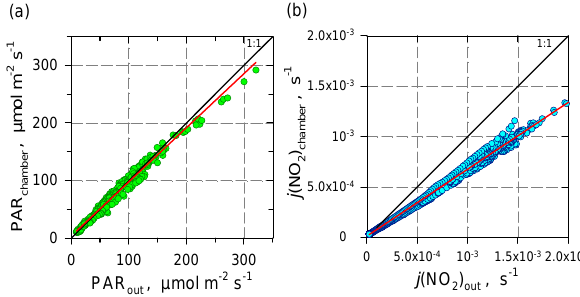
Fig. 9. Simultaneous measurements of radiation in and outside a Figure 9. Simultaneous measurements of radiation in and outside a chamber. (a) 3 chamber. (a) Photosynthetically active radiation PAR (slope=0.94, Photosynthetically active radiation PAR (slope = 0.94, R 2 = 0.98, n = 456), (b) photolysis rate 4 R 2 =0.98, n =456), (b) photolysis rate j (NO 2 ) (slope=0.66, j ( NO 2 ) (slope = 0.66, R 2 = 0.99, n = 1440). The black line indicates the 1:1 line and the red 5 R 2 = 0.99, n =1440). The black line indicates the 1:1 line and the line represents the linear fit on the data points. 6 red line represents the linear fit on the data 7